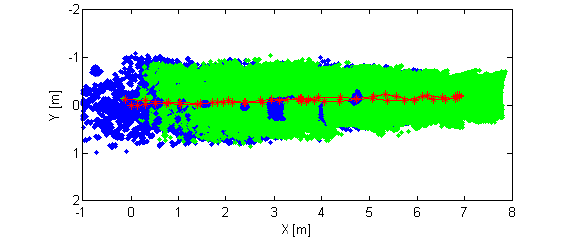
Figure 4: Projection of the estimated trajectory and thinned point cloud data onto the XY -plane.